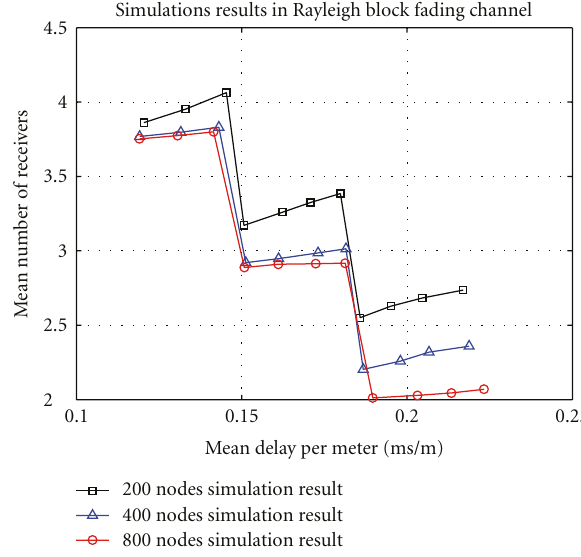
Figure 8: Simulation results about EDRb-DDR tradeo ff in di ff erent node densities